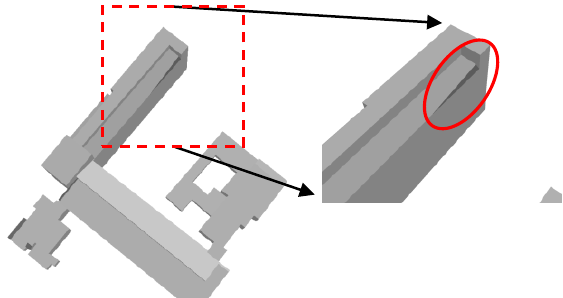
Figure 14. Building roof model derived from wrong labelling of